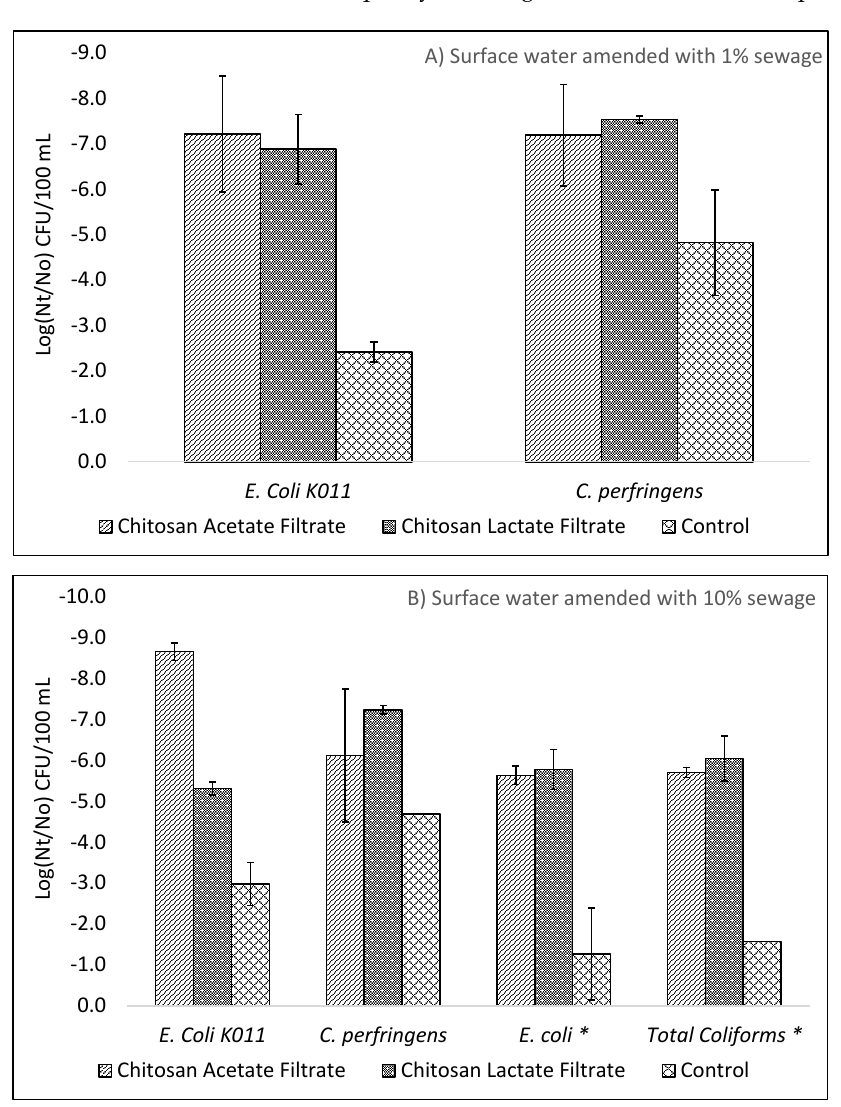
Figure 1. ( A , B ) Average bacterial and surrogate protozoa ( C. perfringens spores) log 10 reductions after pretreatment with 30 mg/L chitosan acetate or chitosan lactate followed by ceramic filtration for natural surface water amended with ( A ) 1% pasteurized sewage and ( B ) 10% pasteurized sewage (error bars indicate standard deviation). Bacteria with * in ( B ) indicate wild type bacteria derived from unpasteurized sewage.